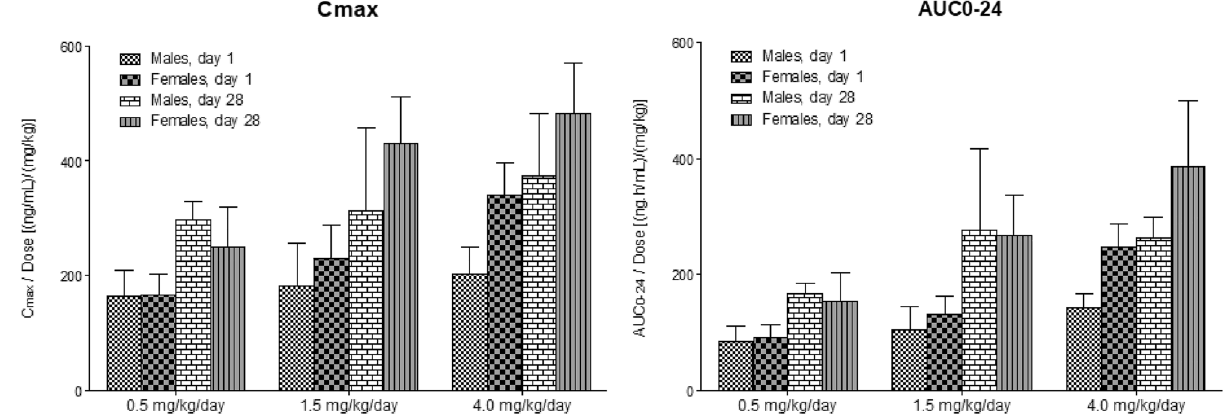
Figure 4. Mean maximum plasma concentrations (C max ) of SET-M33 and mean areas under the plasma concentration–time curves (AUC 0-24 ), on day 1 and day 28 of 4 weeks of daily intravenous (infusion) administration of SET-M33 to beagle dogs at 0.5, 1.5 and 4.0 mg/kg/day. AUC 0-24 area under the plasma concentration–time curve in 24-h dosing intervals, C max maximum plasma concentrations. Columns and bars represent group mean values and standard deviations, respectively. The graphs were plotted using GraphPad Prism for Windows version 5.03, GraphPad Software, San Diego, California USA, www. graph pad. com. Statistical analysis is not applicable to these